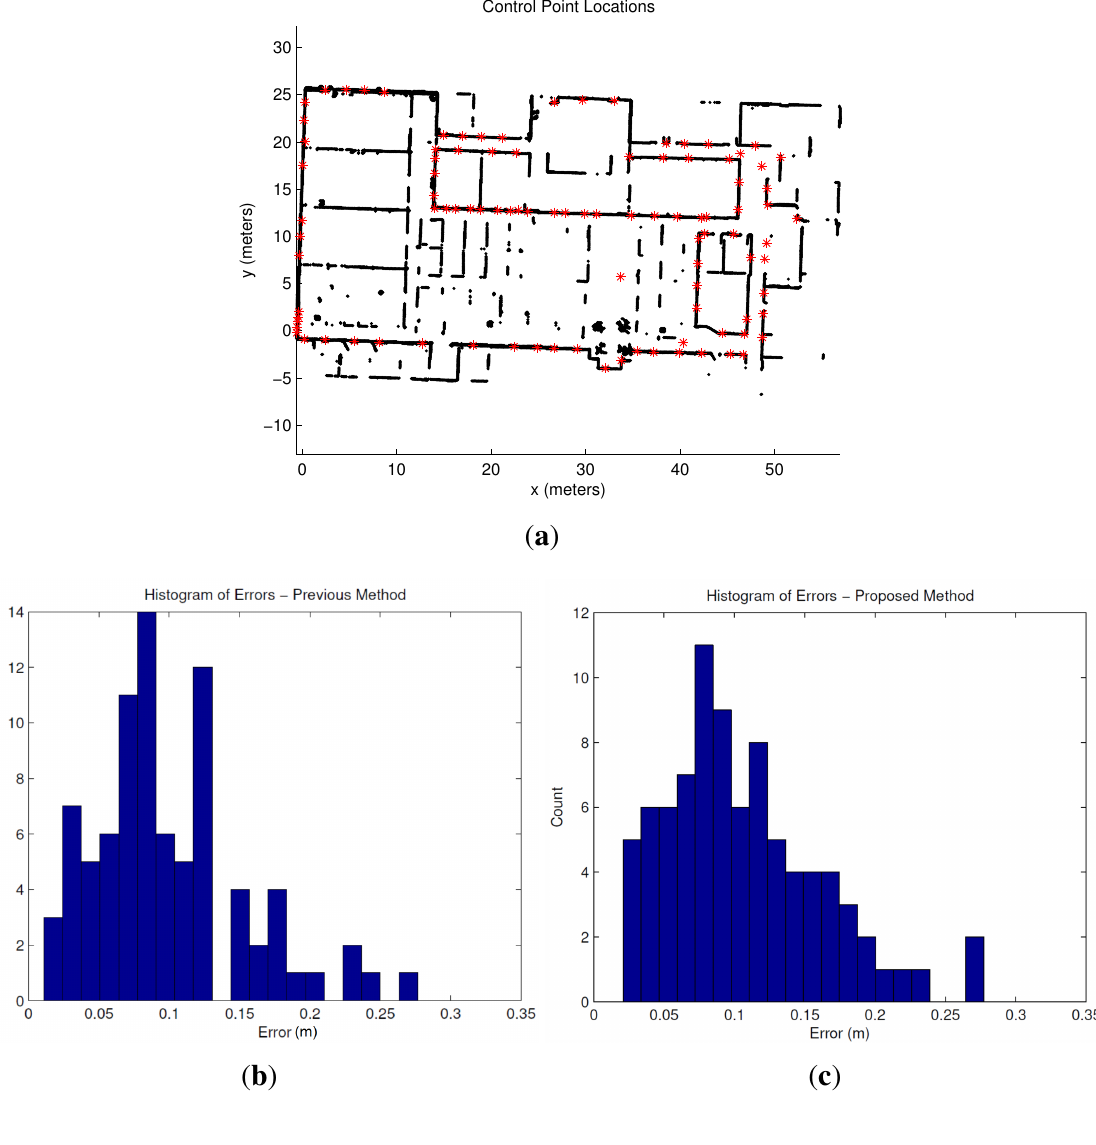
( e ) The loop closure